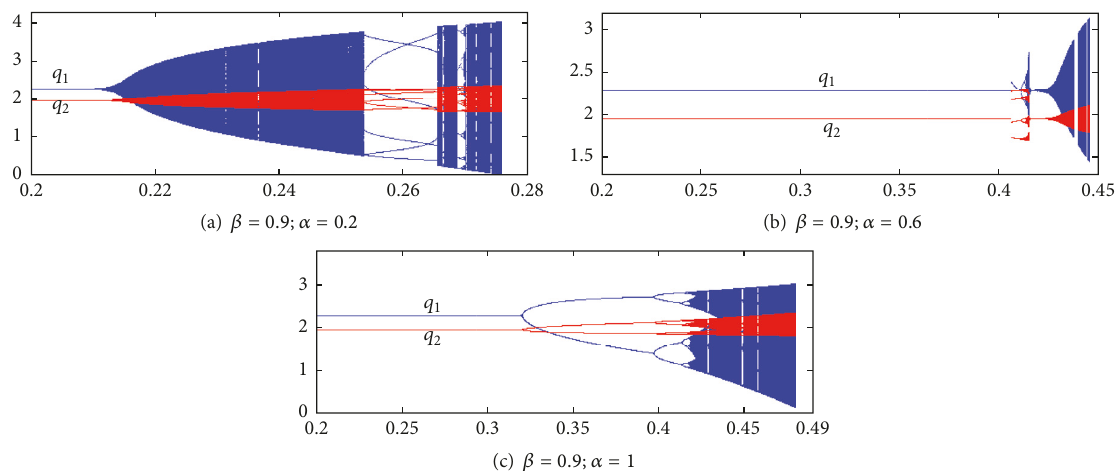
Figure 3: Bifurcation diagrams with respect to the adjustment speed V for the same 𝛽 and different 𝛼